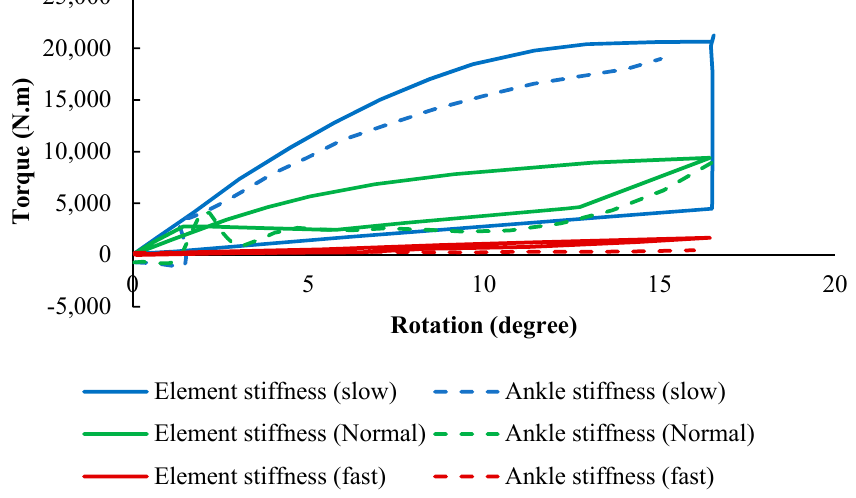
Figure 24. The stiffness results for SMA tube undergoing multiaxial loading (simulation) in comparison with that of the healthy ankle in normal, slow and fast walking [53].